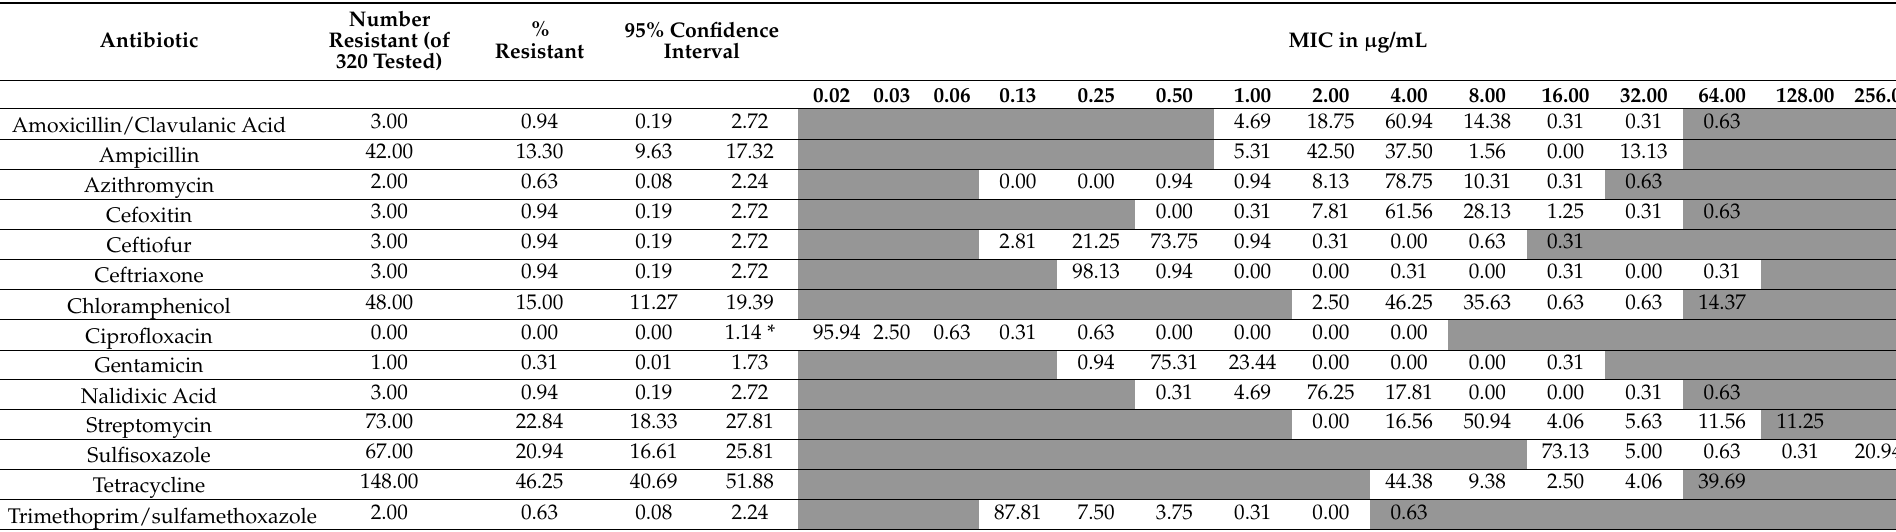
Table 3. Number and percentage (with 95% CI) of E. coli isolates that were resistant and the distribution of isolates (%) across the observed minimum inhibitory concentrations (MIC) for each antibiotic. Black vertical lines indicate the human medical interpretive breakpoint CLSI (or NARMS). Grey boxes indicate unmeasured values above and below highest and lowest limit of assayed antibiotic concentrations, respectively. Isolates which exceeded growth at the highest antibiotic concentration were placed into the next highest MIC